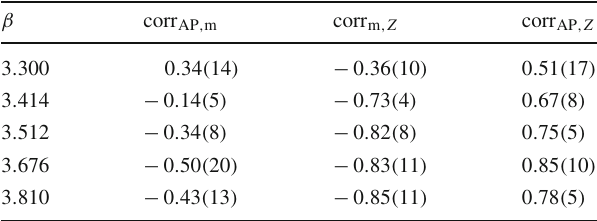
Table 9 Correlations between the estimators R AP , R m and R Z for the β -values used in our